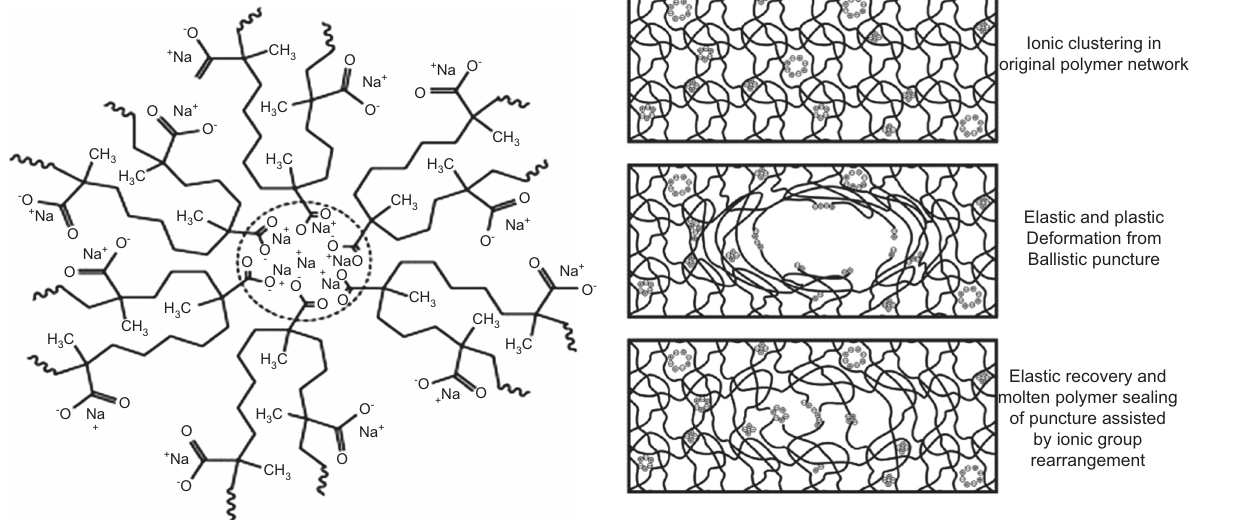
Figure 14 Schematic image of the structure of an ionomer (reprinted with permission from [65]). Copyright 2008, Elsevier.